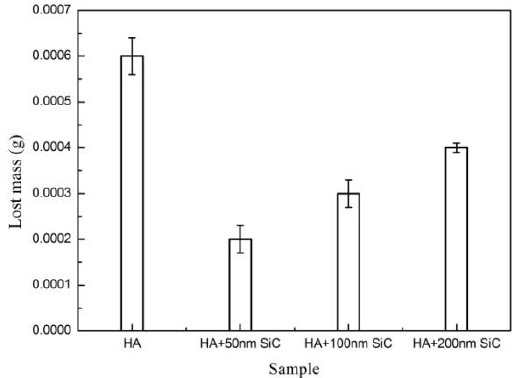
Figure 11. Calcium concentration of different SiC particle (200 nm) concentrations.